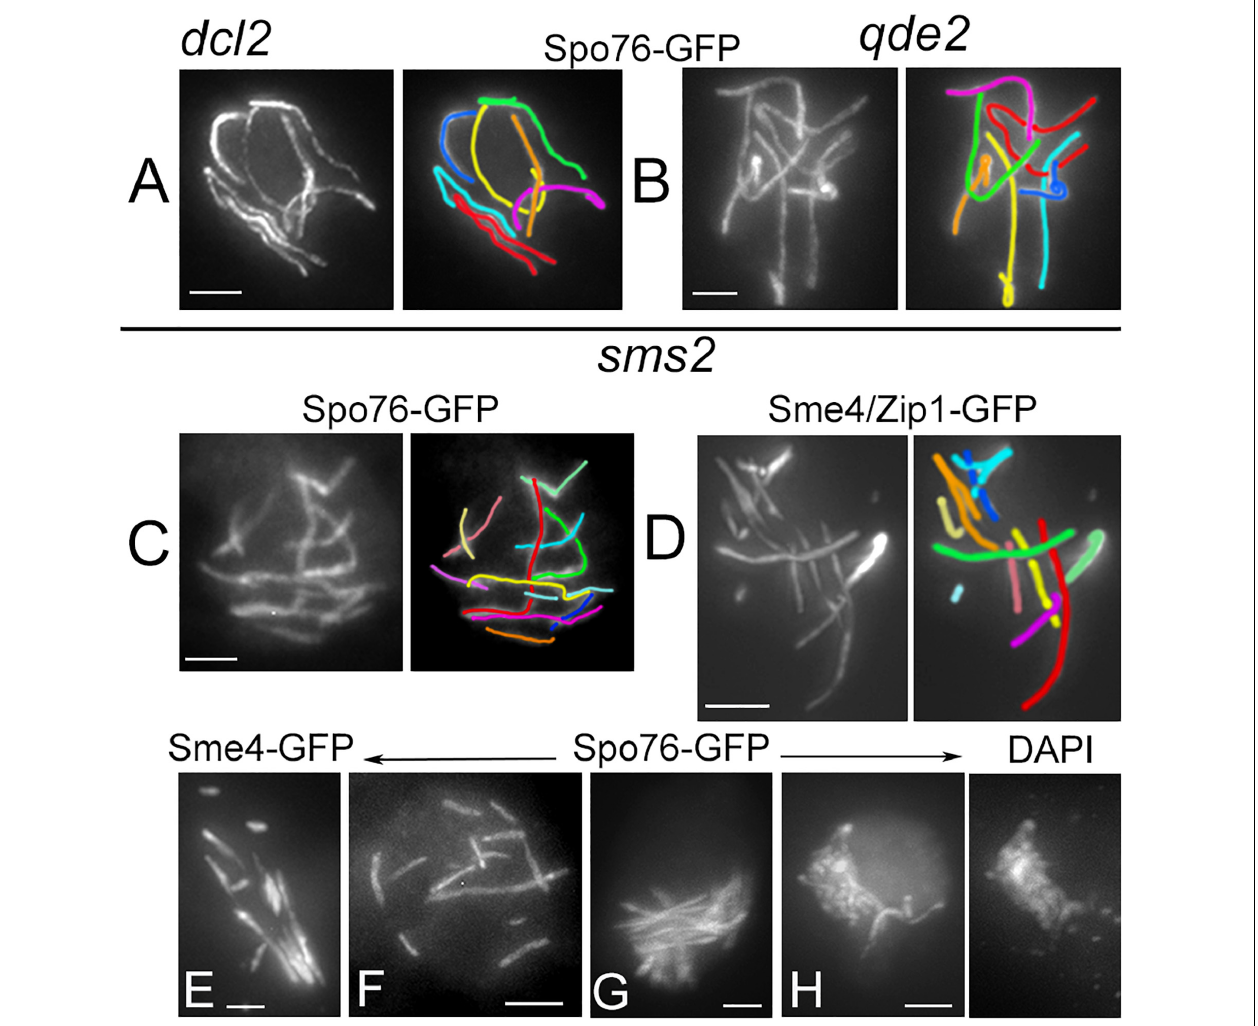
FIGURE 3 | Defective SC formation in sms2 when compared with dcl2 and qde2 . (A–H) SCs are marked by Spo76/Pds5-GFP or Sme4/Zip1-GFP. (A,B) SCs extend from telomere to telomere in pachytene nuclei of dcl2 (A) and qde2 (B) ; the seven homologs are distinguishable by their lengths and colors. (C–H) Examples of abnormal SCs in sms2 pachytene nuclei. (C,D) Two examples with 12 and 11 SC segments in mid-pachytene nuclei (by ascus size), and corresponding colors. (E,F) SCs are either stiff and close (E) or widely separated (F) . (G) Example of stiff and intermingled SCs. (H) Late pachytene nucleus with highly intermingled SCs and, right, corresponding DAPI. Bars, 2 µ